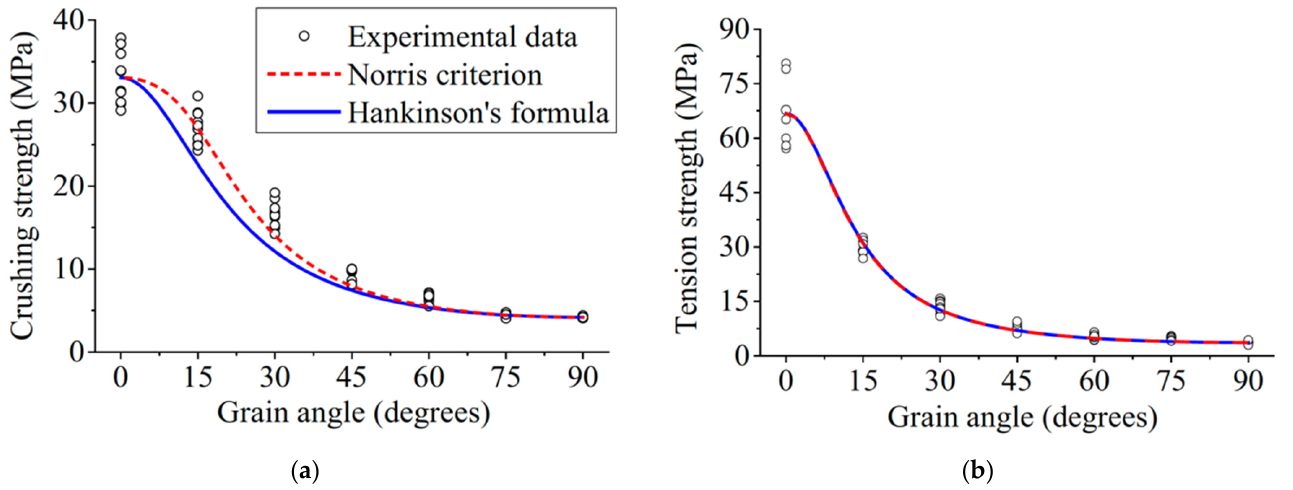
Figure 9. Strengths of Korean Pine as a function of grain angle in ( a ) compression and ( b ) tension. From [85].